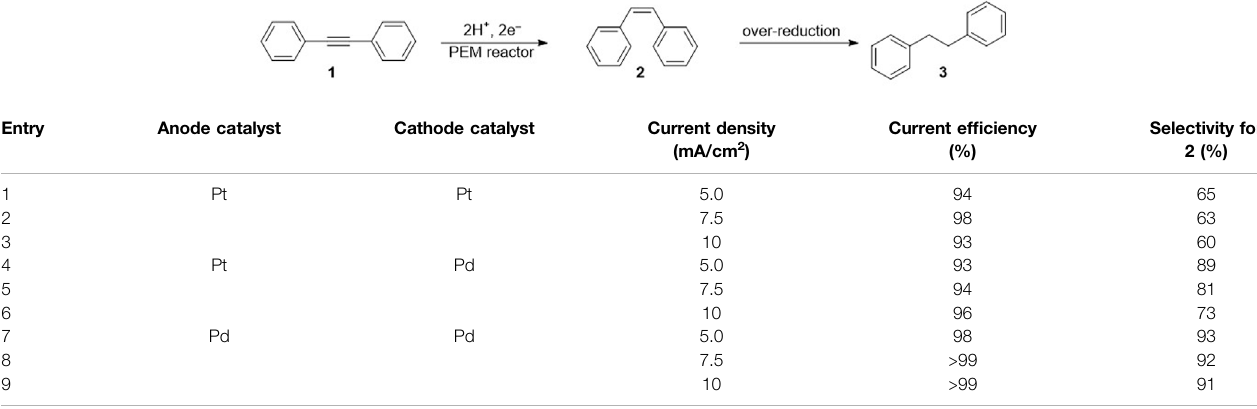
TABLE 1 | Initial investigation of the semihydrogenation of 1 in the conventional PEM reactor, varying the anode, cathode, and current density a .